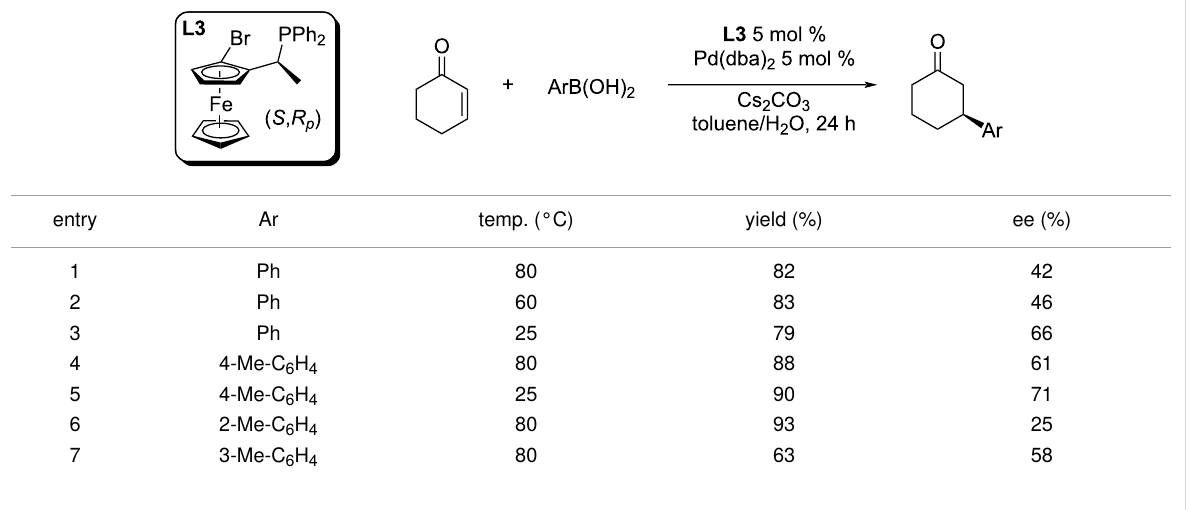
Table 9: Asymmetric addition of arylboronic acids to 2-cyclohexenone catalysed by L3 /Pd(dba) 2 [39].